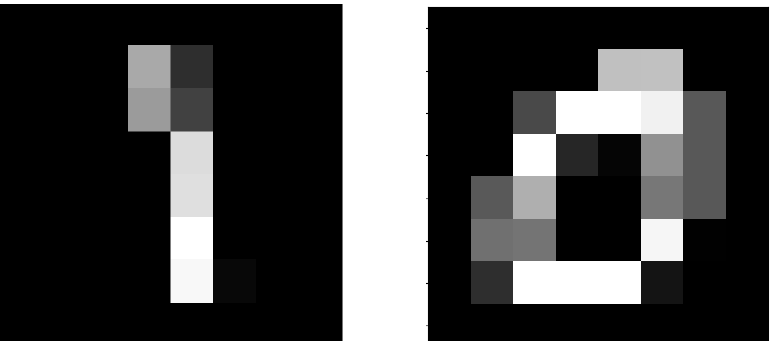
Figure 4. Example of images for the “zero” and “one” digits for the MNIST handwritten digits dataset. Images were compressed to 8 × 8